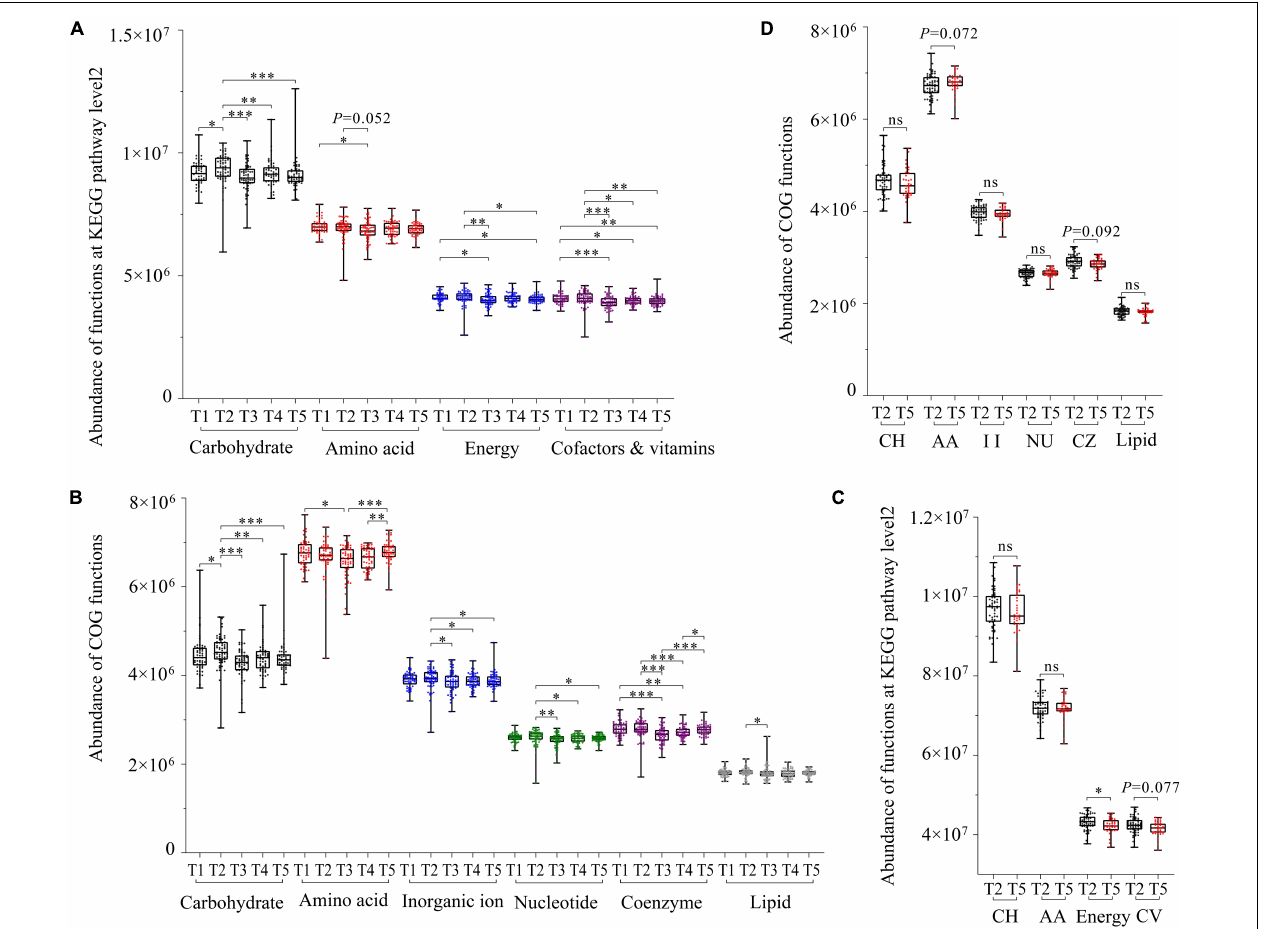
FIGURE 4 | Gut microbial function prediction and seasonal difference analysis based on KEGG and EggNOG databases. Seasonal difference analysis of the main function of gut microbiota of the FMD based on the KEGG database (A) and EggNOG database (B) . Seasonal difference analysis of the main function of gut microbiota of the AMD based on the EggNOG database (C) and KEGG database (D) . ∗ p < 0.05 (Wilcoxon rank-sum test), ∗∗ p < 0.01 and ∗∗∗ p < 0.001. ns, not